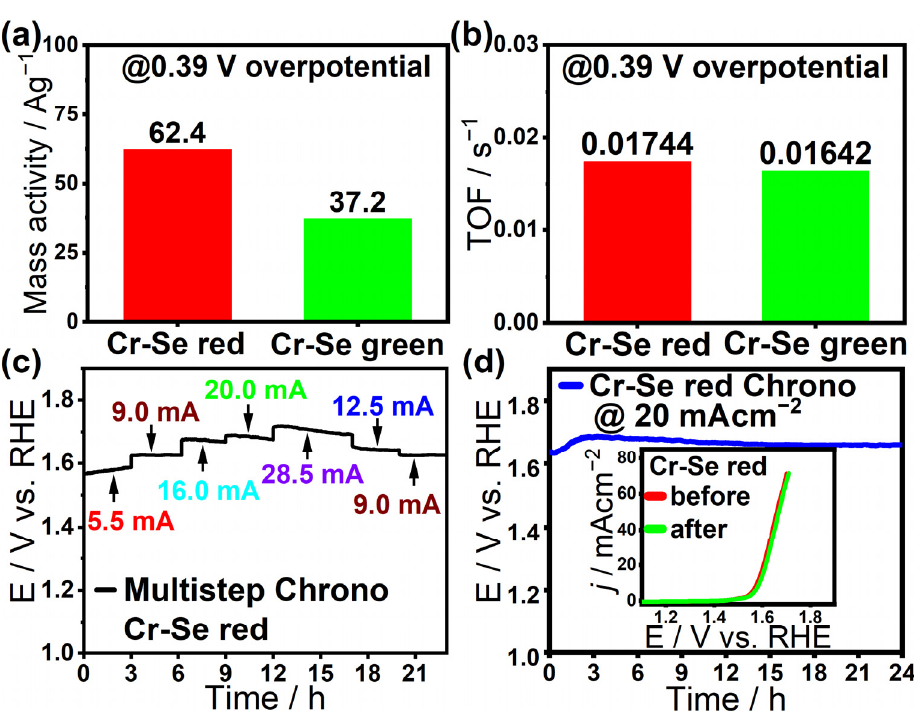
Figure 5. Electrocatalytic performance of Cr–Se red and Cr–Se green complexes. ( a ) Mass activity; ( b ) Turnover frequency (TOF); ( c ) Multistep chronoamperometry study of Cr–Se red at various current densities.; ( d ) Chronoamperometry at constant current density. Inset shows the comparison of OER activity before and after long-term chronoamperometry.